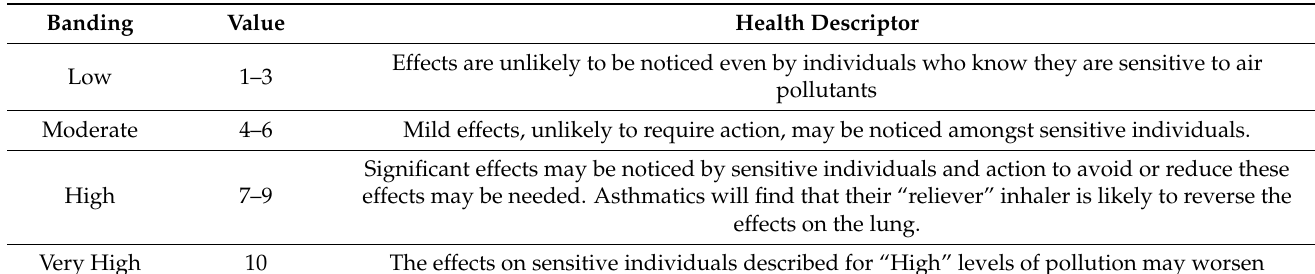
Table 2. Air Quality Indices and health effect